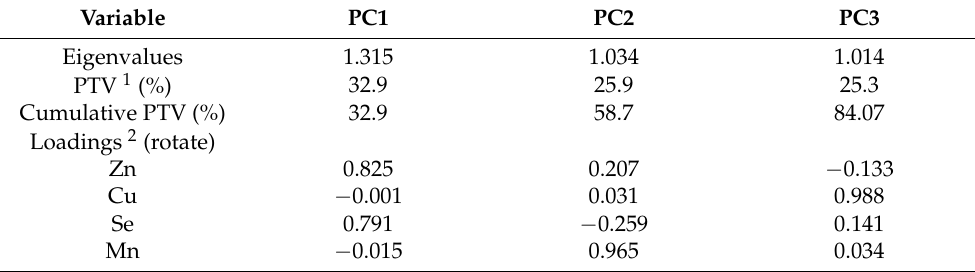
Table 4. Combined analysis of plasma trace elements. Principal component